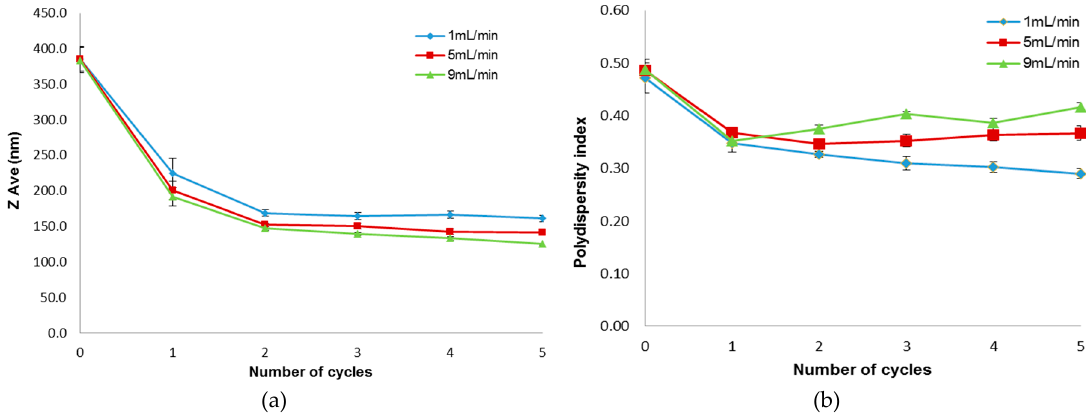
Figure 3. Influence of flow rate on the ( a ) particle size and ( b ) polydispersity index of extruded liposomes (Mean ± SEM, n = 6).